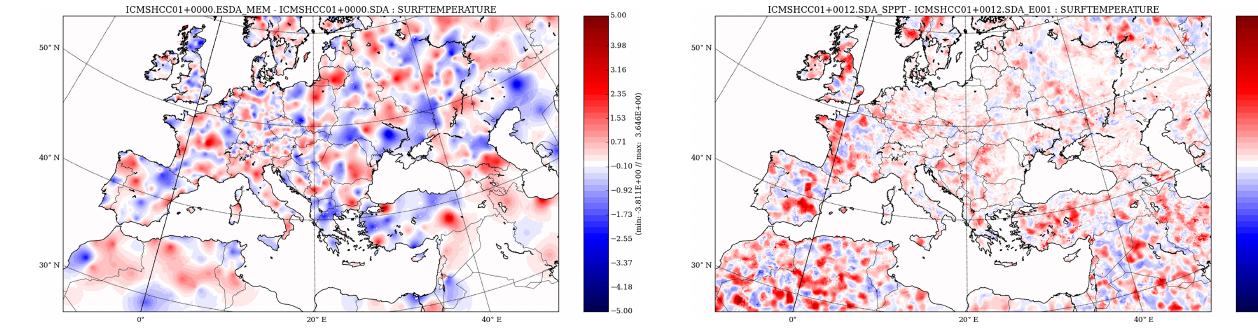
Figure 5. Surface temperature perturbation by stochastic physics method (differences after 12h of